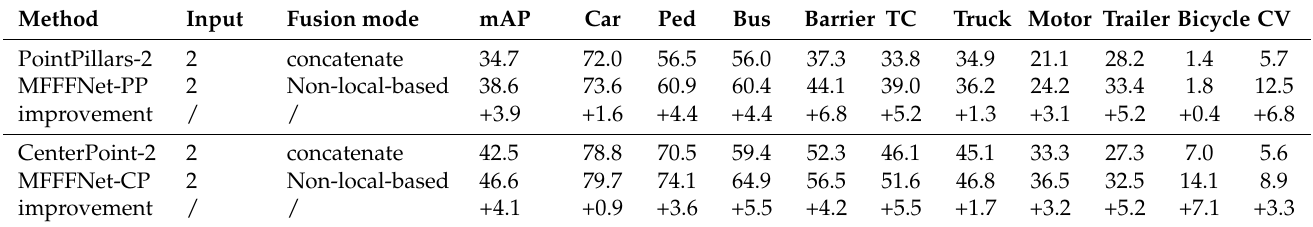
Table 3. Comparison between MFFFNet, PointPillars, and